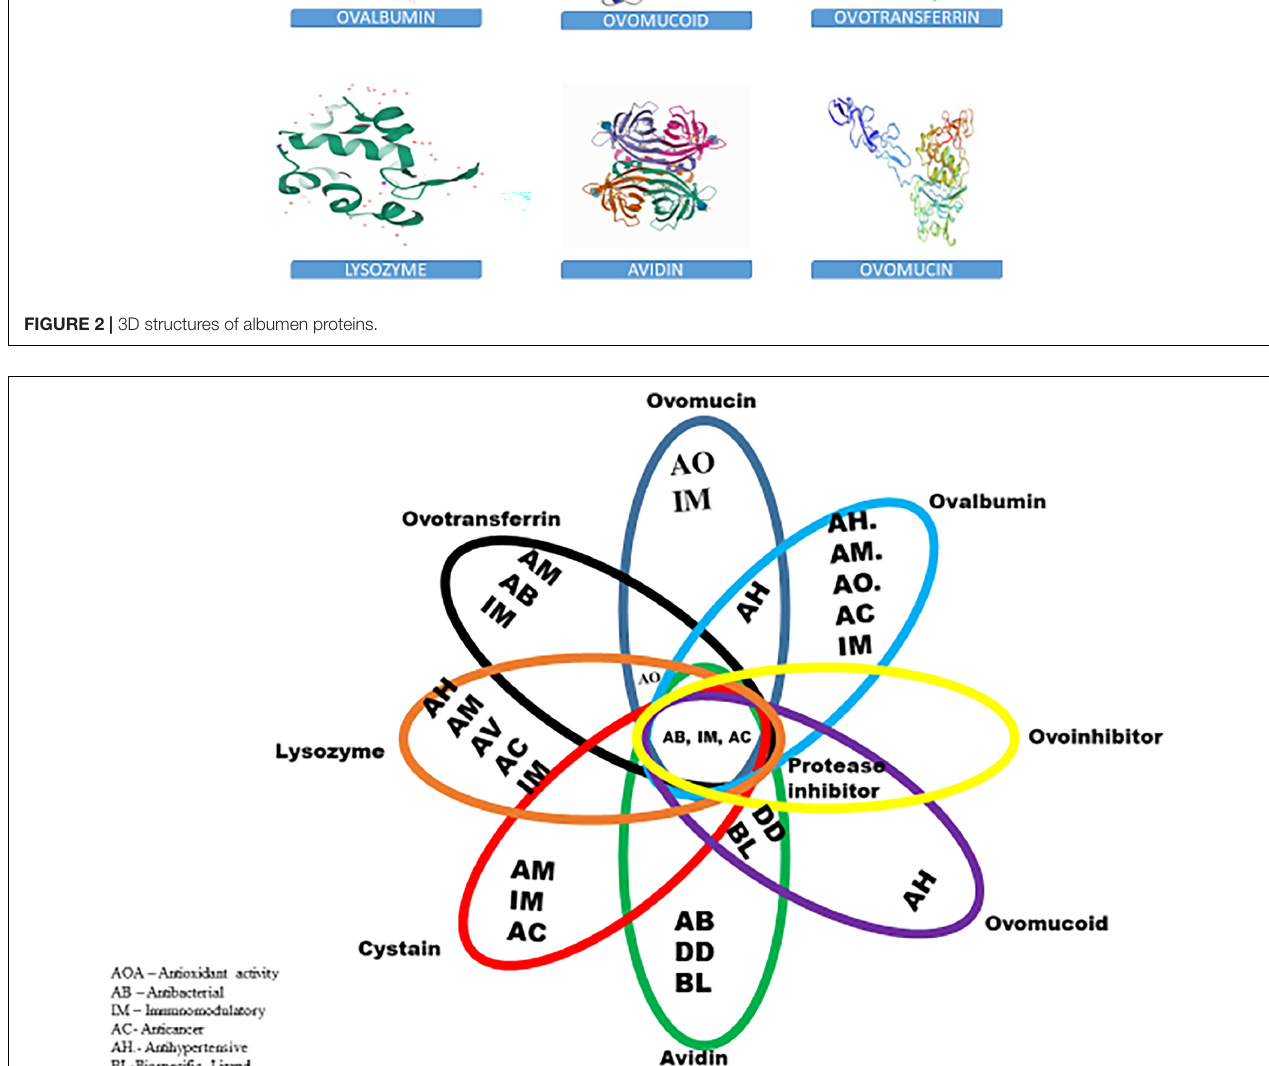
FIGURE 3 | Biological functions of albumen